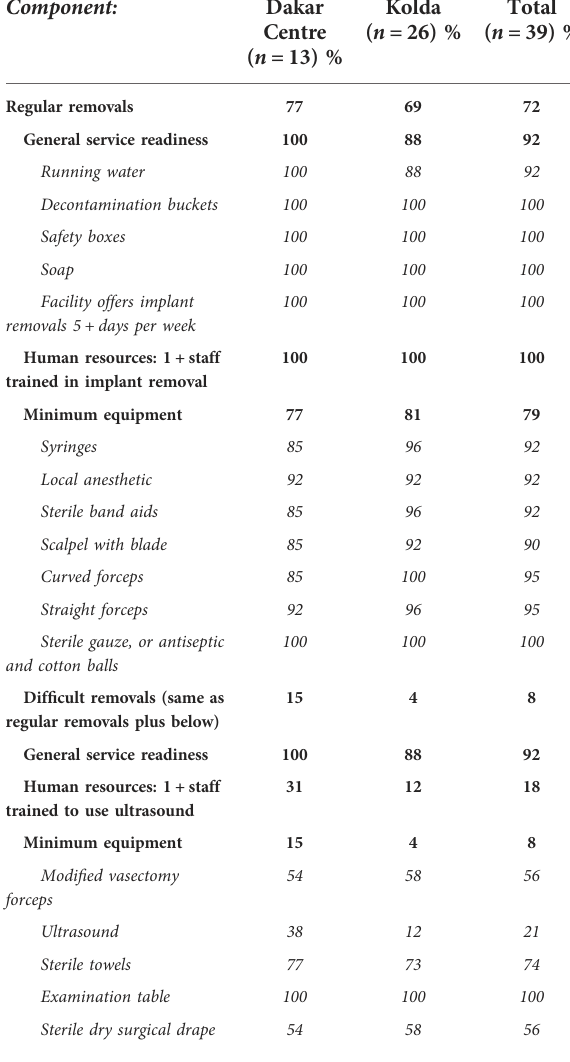
TABLE 2 Readiness to handle regular and dif fi cult removals by component.